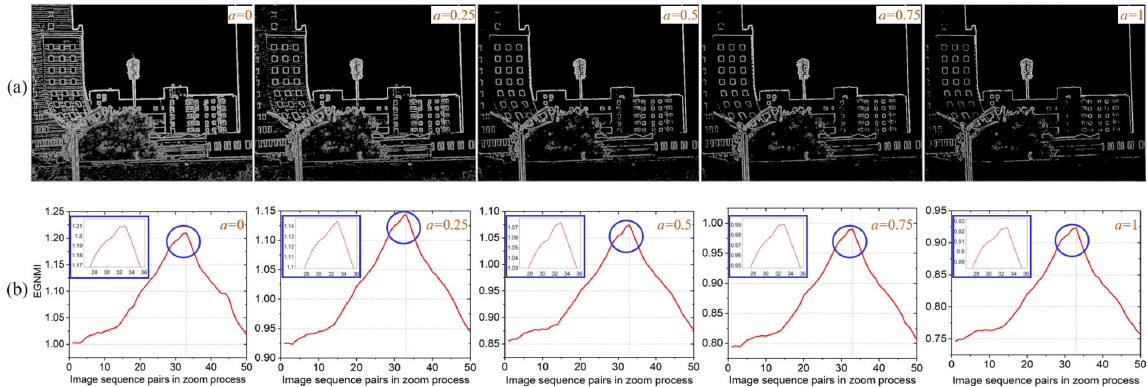
Figure 8. Experimental results under different values of a : ( a ) edge images under different values of a ; and ( b ) EGNMI curves under different values of a (the details in blue circles are enlarged to